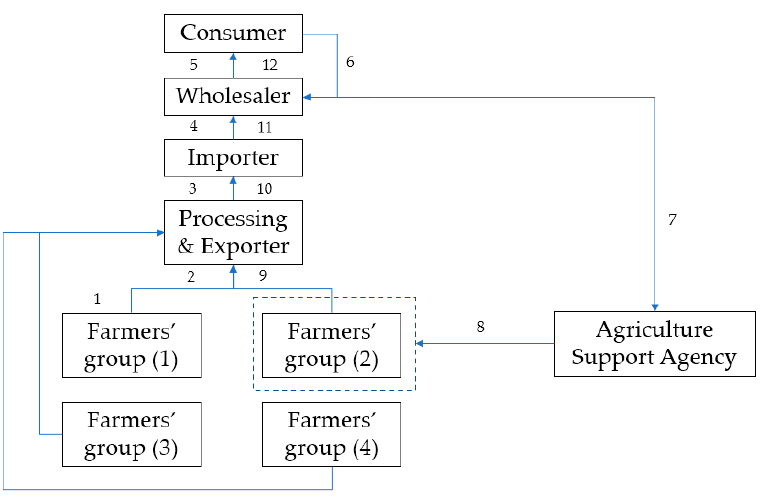
Figure 1. The research hypothesis. Source: Researcher, 2017